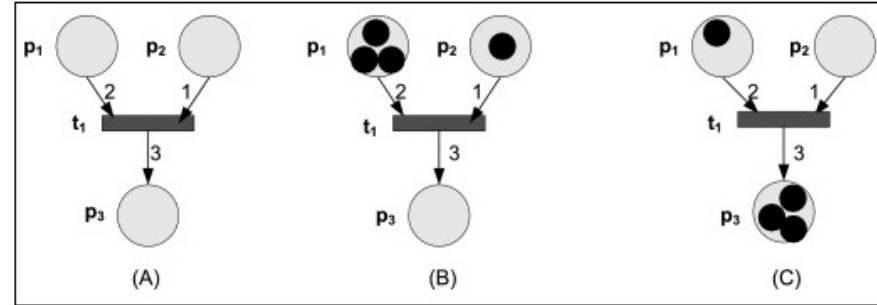
Figure 1. Firing rules of